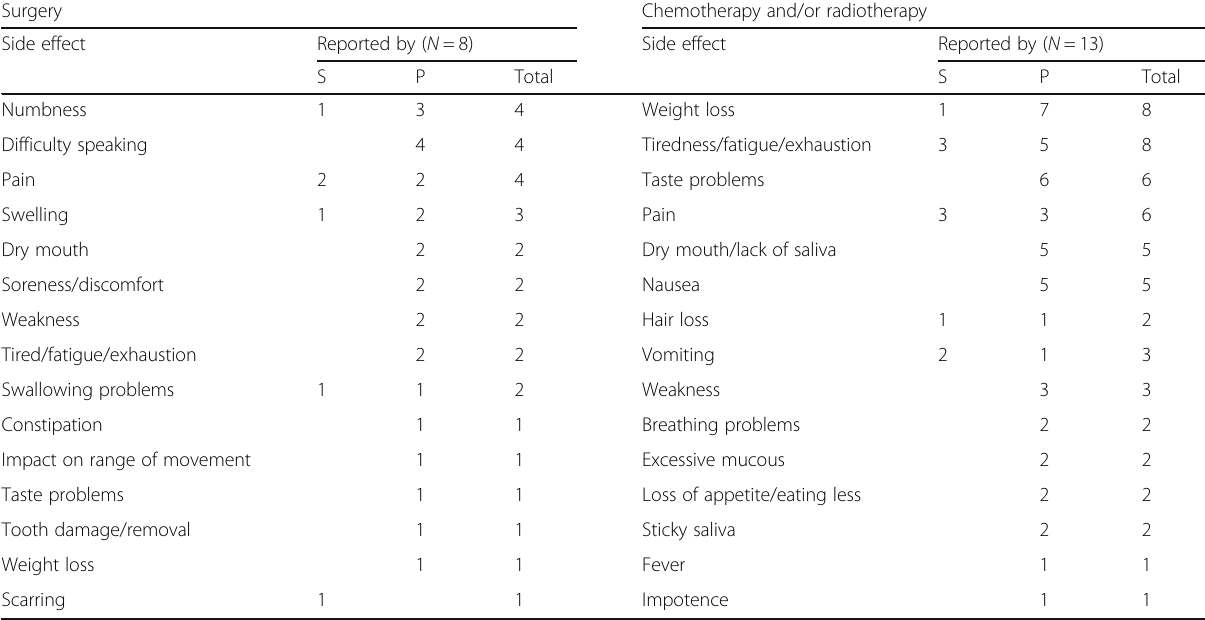
Table 4 Side effects of surgery and chemotherapy and/or radiotherapy in patients with HNSCC Surgery Chemotherapy and/or radiotherapy Side effect